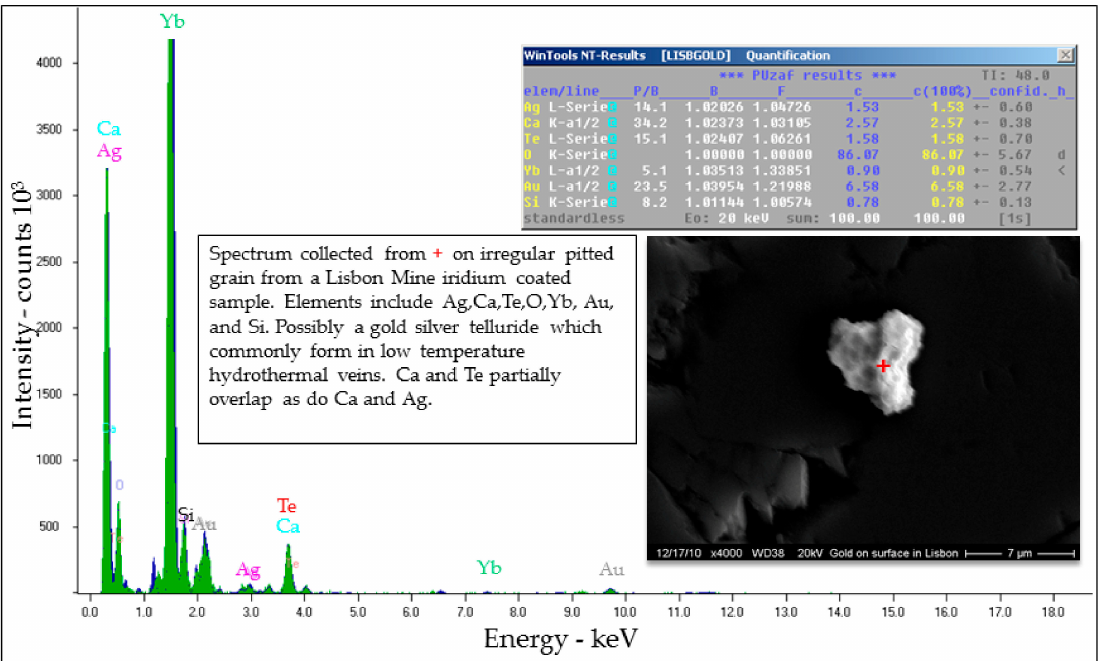
Figure A1. EDS spectrum of Au mineral from Lisbon mine sample. The Y-axis shows the counts in 10 3 (number of X-rays received and processed by the detector) and the X-axis shows the energy level of those counts in kilo-electron volts